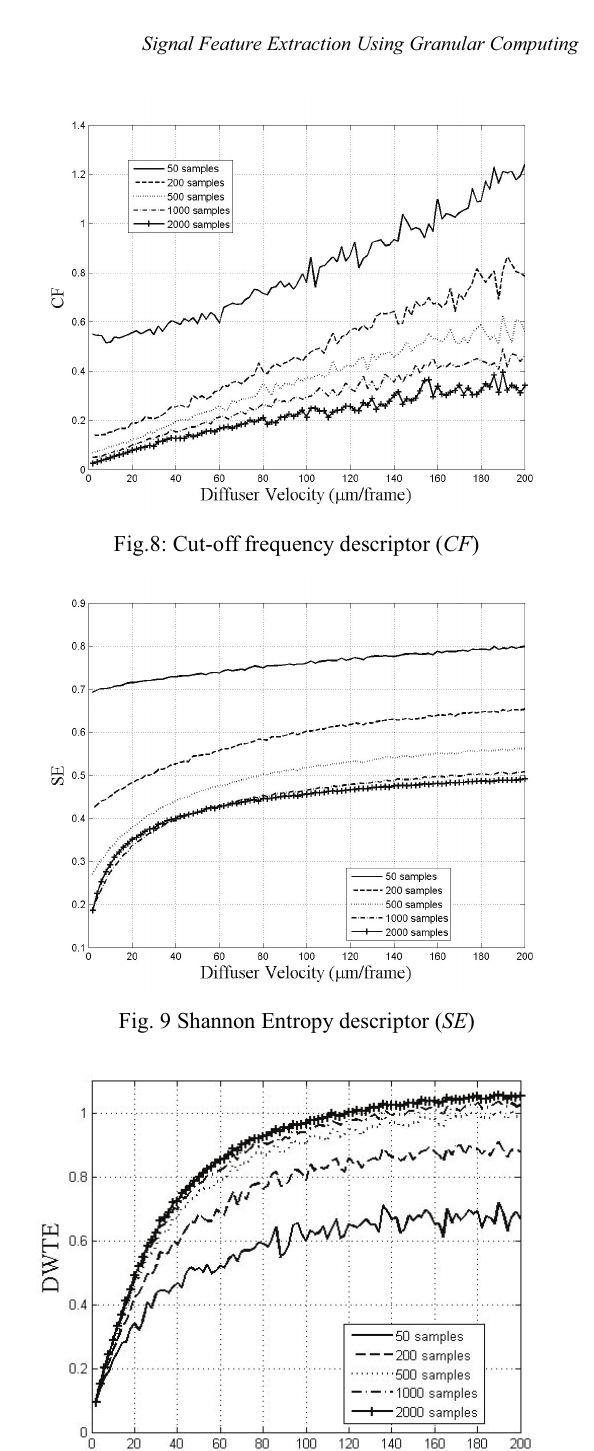
Fig. 10 Discrete Wavelet Transform Entropy ( DWTE